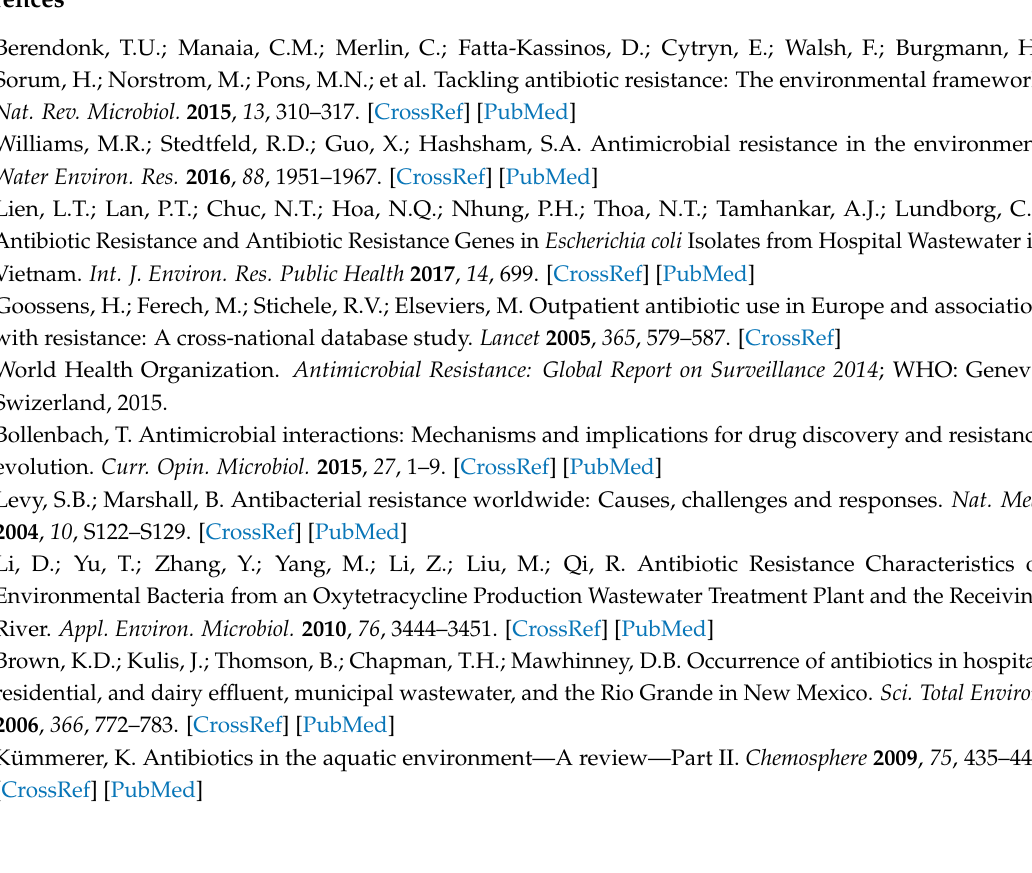
Table S1: Description of sampled sites; Table S2: Colony Forming Unit per mL (CFU/mL) for the Environmental Samples under study on Total Plate Count Agar. Figure S1: Map of Nigeria highlighting the study areas: Ogun and Lagos States; Figure S2: A section of the map of Nigeria showing Agbara Industrial Area in Ogun State; Plate S1: Cross-section of the wastewater treatment Plant located in Agbara Industrial Estate, in Ogun State, Nigeria. Author Contributions: Conceptualization, A.O. (Amarachukwu Obayiuwana), A.O. (Adeniyi Ogunjobi) and M.Y.; Methodology, A.O. (Amarachukwu Obayiuwana), M.I. and M.Y.; Software, M.Y.; Validation, A.O. (Amarachukwu Obayiuwana) and M.Y.; Formal Analysis, A.O. (Amarachukwu Obayiuwana); Investigation, A.O. (Amarachukwu Obayiuwana); Resources, M.Y.; Data Curation, A.O. (Amarachukwu Obayiuwana); Writing—Original Draft Preparation, A.O. (Amarachukwu Obayiuwana); Writing—Review and Editing, A.O. (Amarachukwu Obayiuwana), A.O. (Adeniyi Ogunjobi), M.I. and M.Y.; Visualization, M.I. and M.Y.; Supervision, A.O. (Adeniyi Ogunjobi) and M.Y.; Project Administration, A.O. (Amarachukwu Obayiuwana) and M.Y.; and Funding Acquisition,